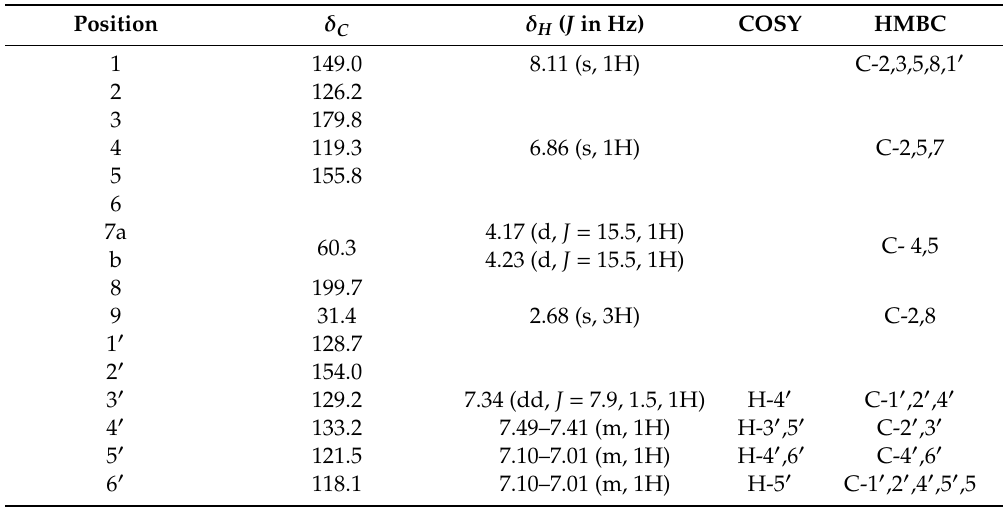
Table 1. 1 H, 13 C NMR, COSY, and HMBC data of compound 1 (400 MHz, 100 MHz; CD 3 OD).